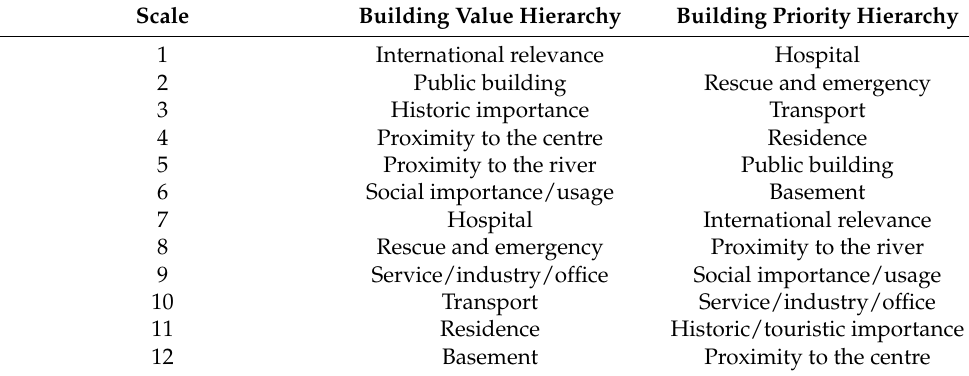
Table 1. List of 12 markers following the order for the “Building Value Hierarchy” and the “Building Priority